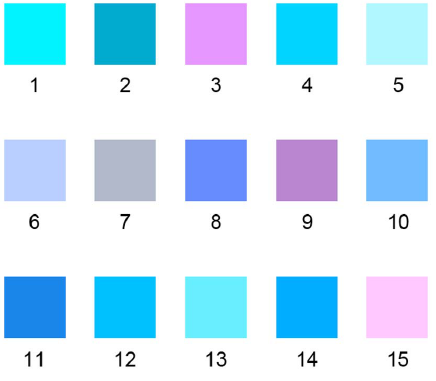
Figure 5. Experiment 2: Color samples.